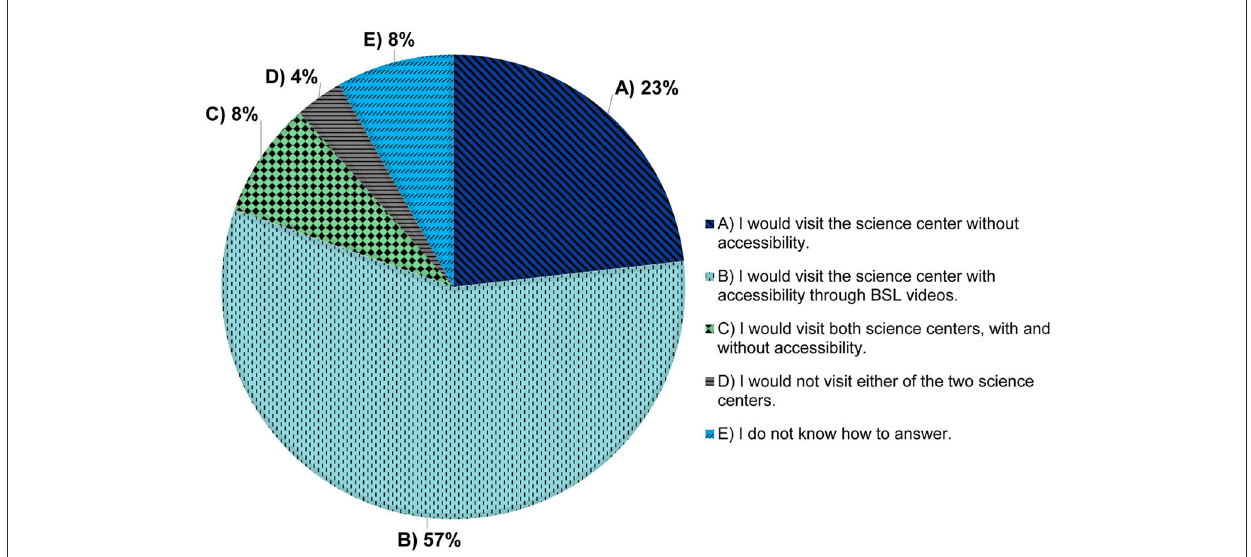
FIGURE5 Percentual data about the question: “If there are two science centers, one with no accessibility for deaf people and another one with accessibility through video in BSL, which one would you visit?” N = 745.